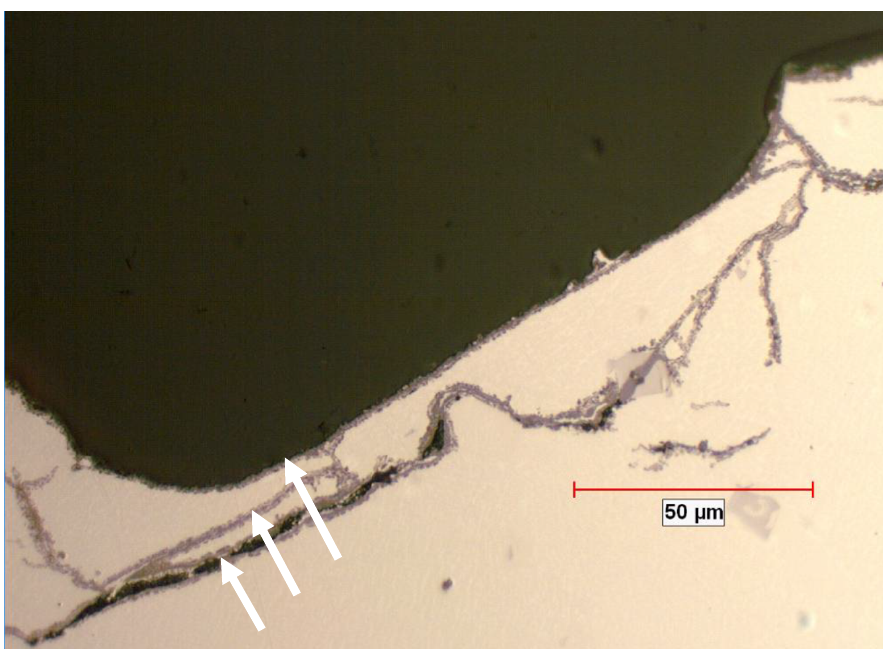
Figure 7. A section through the fracture surface, the main fracture displaying the remaining half of the double oxide film which formed the main pre-crack. Two additional oxidised film-like features, one of which is clearly a double film, form a close group of three parallel cracks (arrowed) [39]. The bifilms identified in the metallographic sections clearly occupy between 50 and 90% of the width of the blade. This leaves relatively little of the area to be